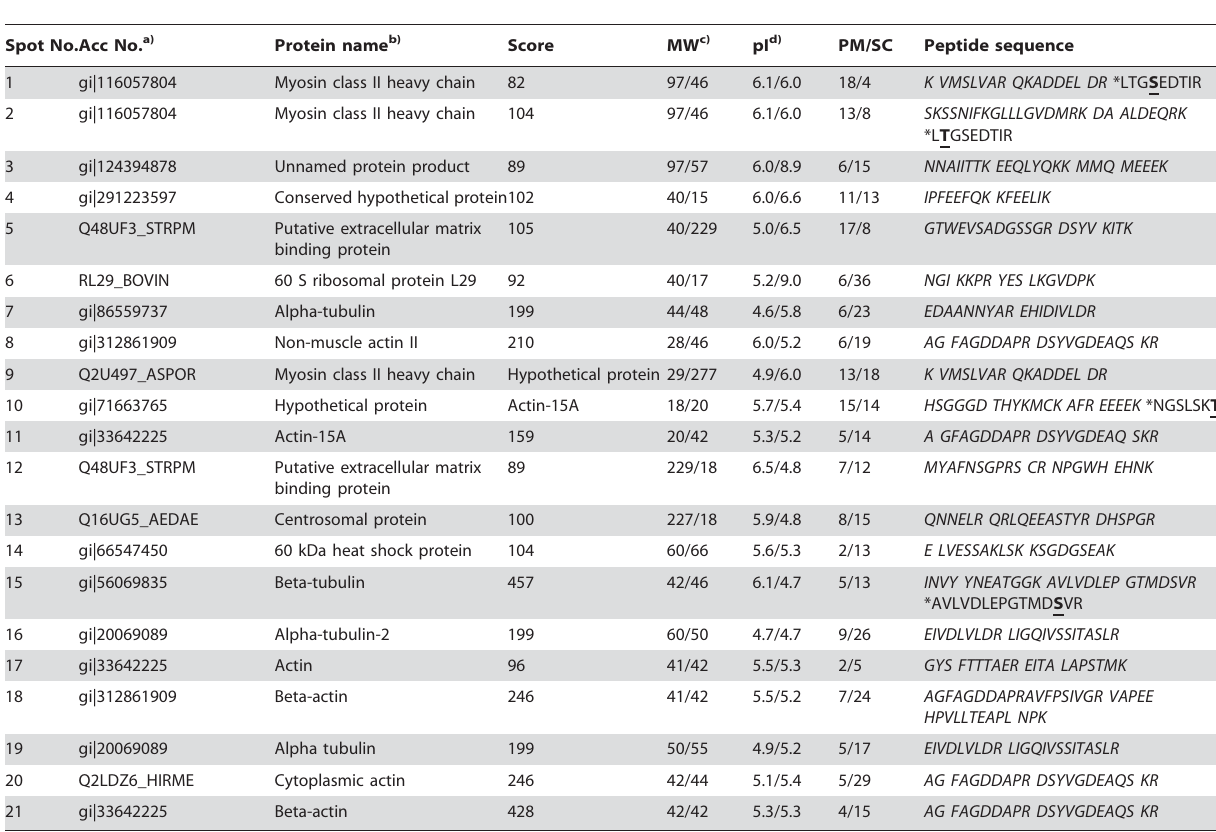
Table 1. Identification of abundant proteins during early development in Neanthes arenaceoentata.